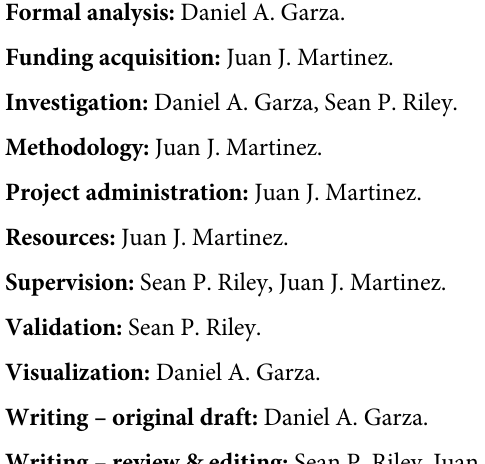
S1 Table. List of